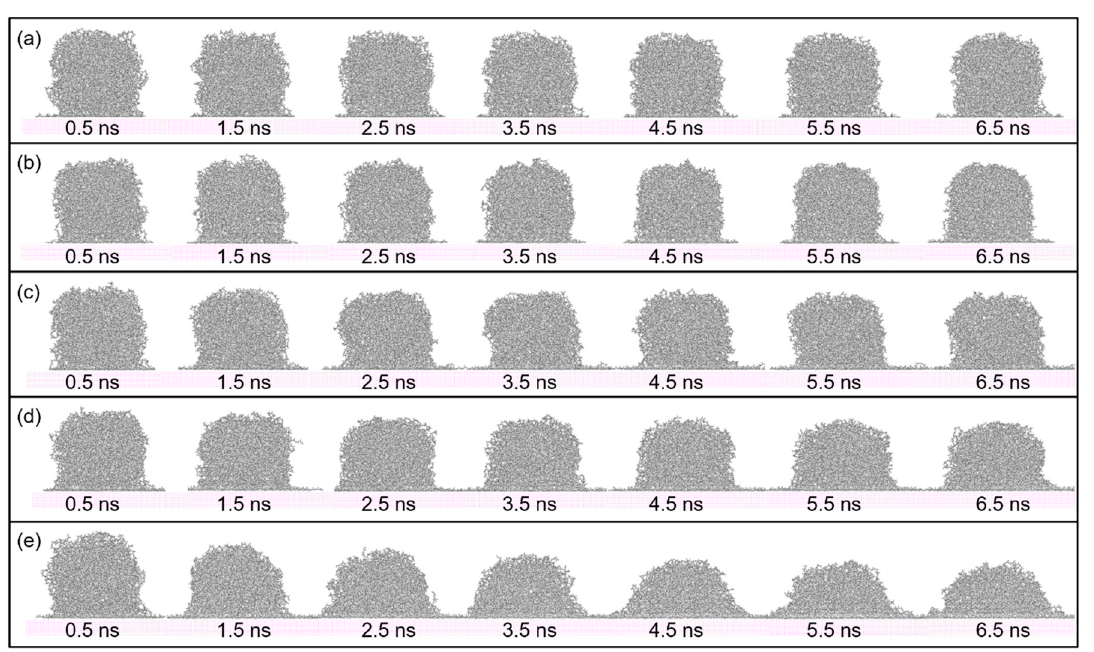
Figure 3. Snapshots of the spreading process of PP droplet with simulation time on the smooth surface. The temperature of PP droplet was ( a ) 383 K, ( b ) 413 K, ( c ) 443 K, ( d ) 473 K and ( e ) 503 K respectively.